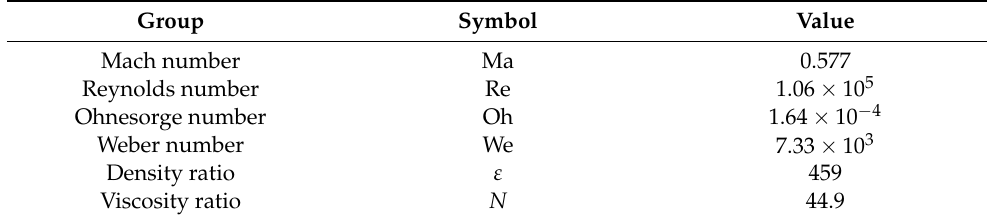
Table 3. Characteristic dimensionless